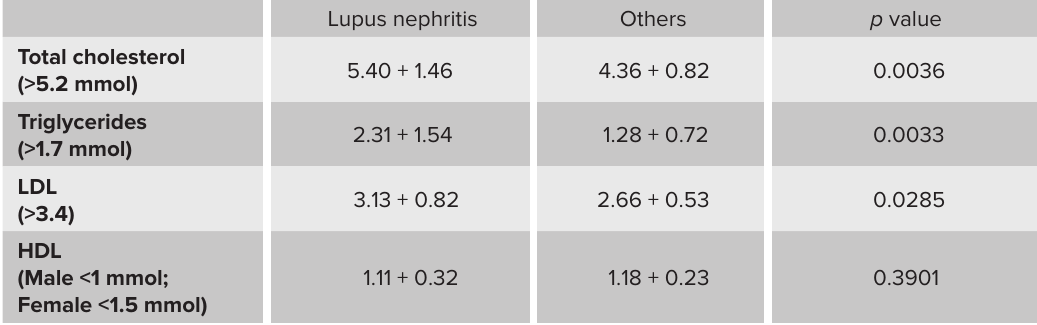
Table 3: The Relationship Between Dyslipidemia and Lupus Nephritis. Lupus nephritis Others